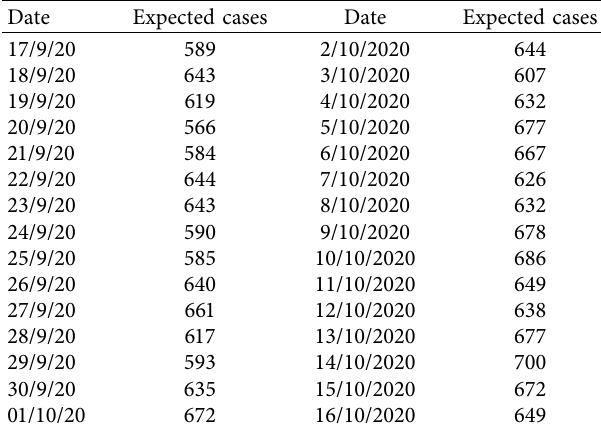
Table 7: The prediction results of daily confirmed COVID-19 cases in Central Africa for the next month as predicted by the ARIMA (2,1,3)